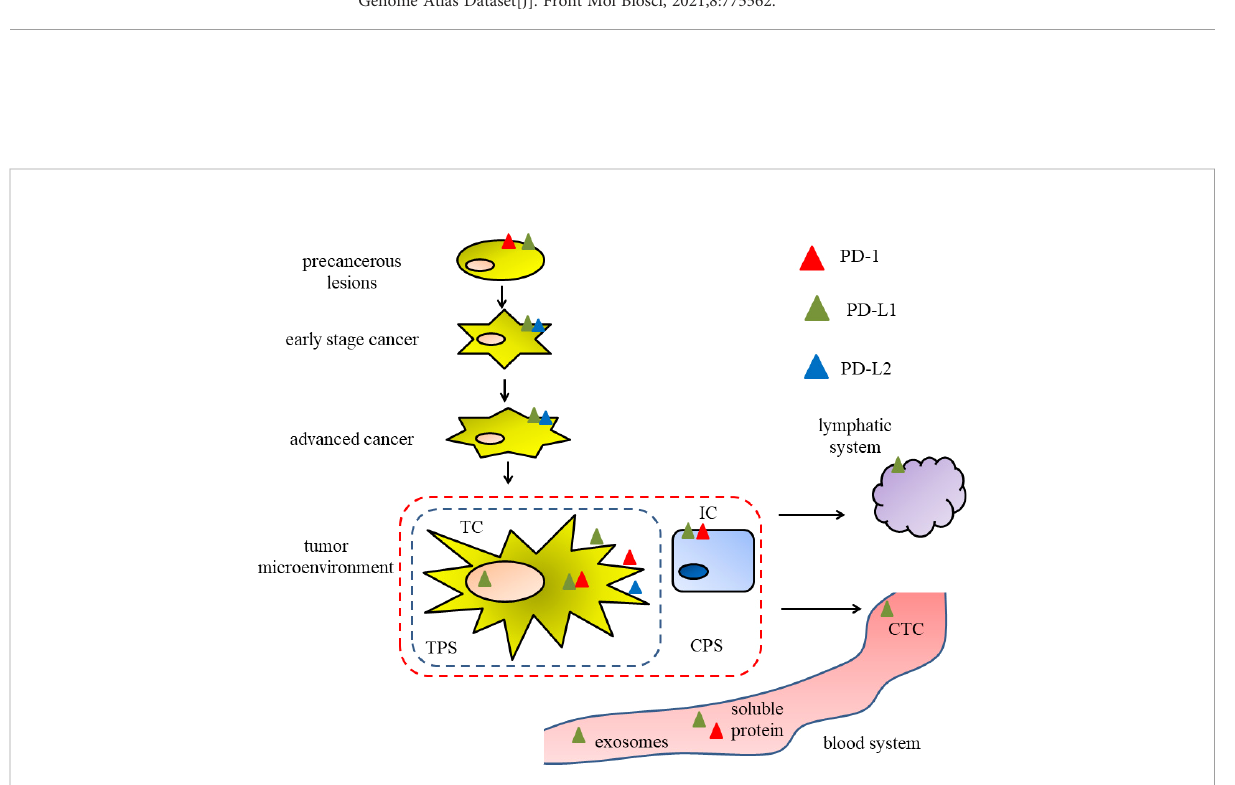
FIGURE 1 Figure 1 The different localizations and forms of PD-1, PD-L1 and PD-L2 in different stages of head and neck cancer, associating with the prognostic